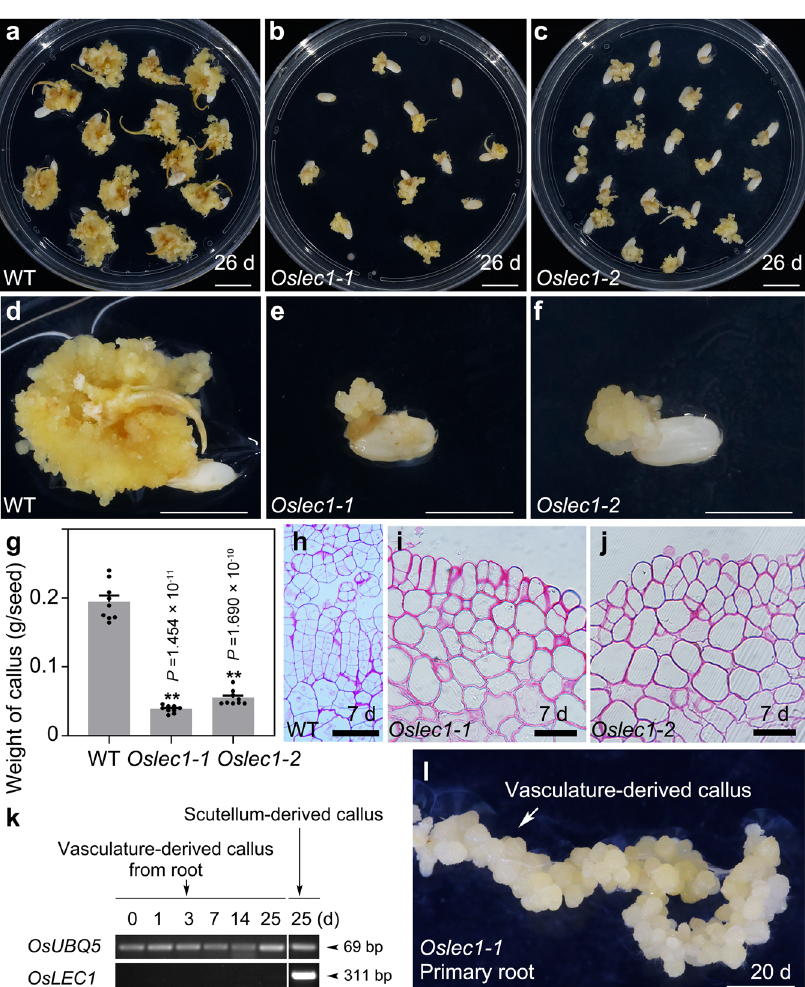
Fig. 5 OsLEC1 is involved in scutellum-derived callus formation. a – f Rice seeds from wild-type ( a , d ), Oslec1-1 ( b , e ), and Oslec1-2 ( c , f ) tissue-cultured on CIM for 26 d. g Statistical analysis of scutellum-derived callus formation in wild-type, Oslec1-1 , and Oslec1-2 on CIM at 16 d. Error bars show SEM with nine biological replicates (10 calli in each replicate). The individual values are indicated by dots. ** P < 0.01 in two-sided Student ’ s t -test compared with the wild- type control. h – j Sections showing cell division of scutellum epidermis from wild-type ( h ), Oslec1-1 ( i ) and Oslec1-2 ( j ) seeds on CIM at 7 d. k RT-PCR analysis of OsLEC1 expression pattern in vasculature-derived callus and scutellum-derived callus (33 cycles). OsUBQ5 serves as the control (30 cycles). Numbers indicate the days cultured on CIM. The bands of OsUBQ5 and OsLEC1 are derived from different gels. The bands from vasculature-derived callus and scutellum-derived callus were separately collected from the same gel, and the experiments were performed under the same conditions. The predicted band sizes were indicated. Two biological repeats were analyzed and showed the same result. l Primary roots of Oslec1-1 tissue-cultured on CIM for 20 d, showing vasculature-derived callus formation. See Fig. 3c for the wild-type control. Scale bars, 1 cm ( a – c ), 5 mm ( d – f ), 50 μ m ( h – j ), 1 mm ( l Third, scutellum-derived and vasculature-derived calli may AtPLTs , and AtIAA14 10,12 – 14,16,18,36 . In rice, OsCRL1 (the require some different molecular and developmental programs for AtLBD16 homologue), OsWOX5 (the AtWOX5 homologue), and their initiation. In Arabidopsis , vasculature-derived callus initiation OsIAA11 (the AtIAA14 homologue) are also required for requires root-organogenesis-related genes, e.g. AtLBD16 , AtWOX5 , vasculature-derived callus formation 7,16 . In contrast, initiation of